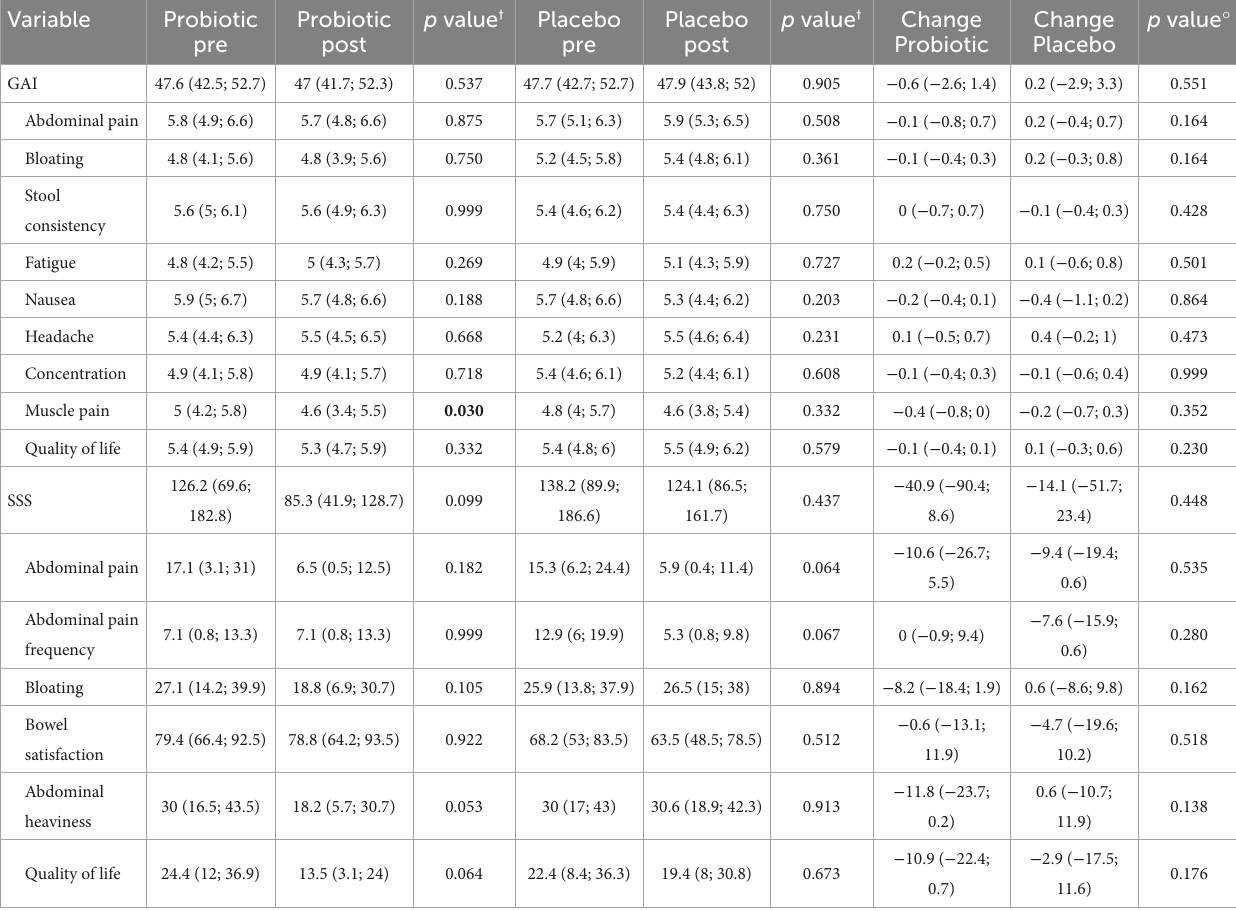
TABLE 4 Effect of the probiotic and placebo supplementation on clinical symptoms. Variable Probiotic